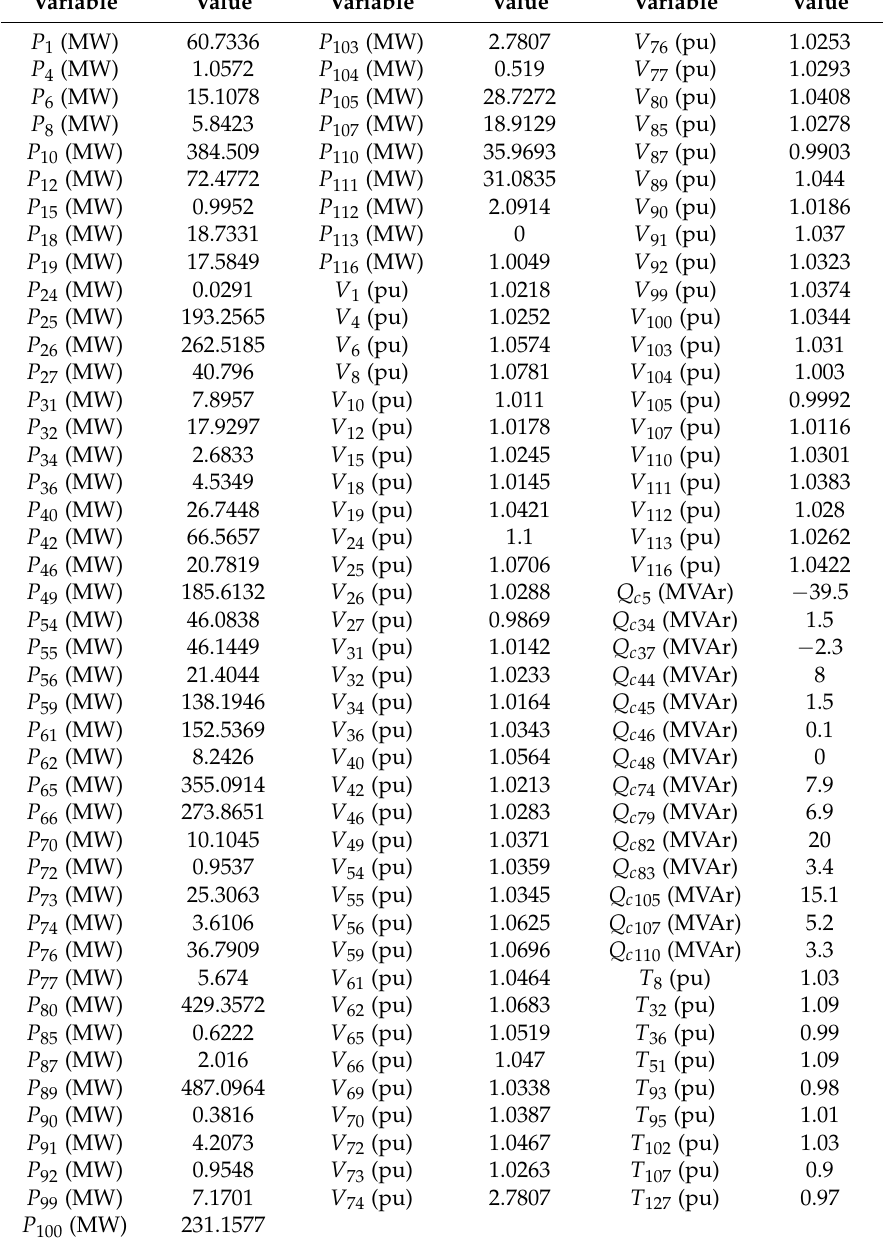
Table A3. Optimal solution obtained by NISSO for the IEEE-118 bus power